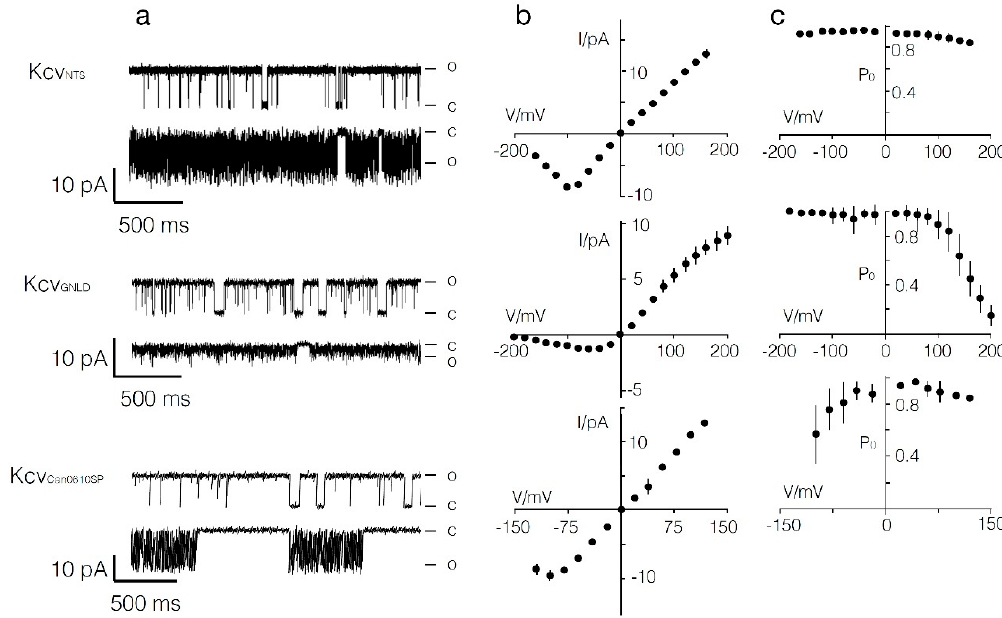
Figure 4. Two of the newly discovered K + channels are active. Characteristic single-channel fluctuations ( a ), mean single-channel I / V relations ( b ), and mean open probabilities ( c ) of Kcv NTS (top row), Kcv GNLD22 (middle row), and Kcv Can0610SP (bottom row) at ± 120 mV. The closed (c) and open (o) levels are indicated along the current traces. Data are means ± s.d. from ≥ 3 independent recordings of channels in the same row. Data were recorded in a DPhPC bilayer with symmetrical 100 mM KCl, 10 mM HEPES, pH 7 in cis and trans chamber.